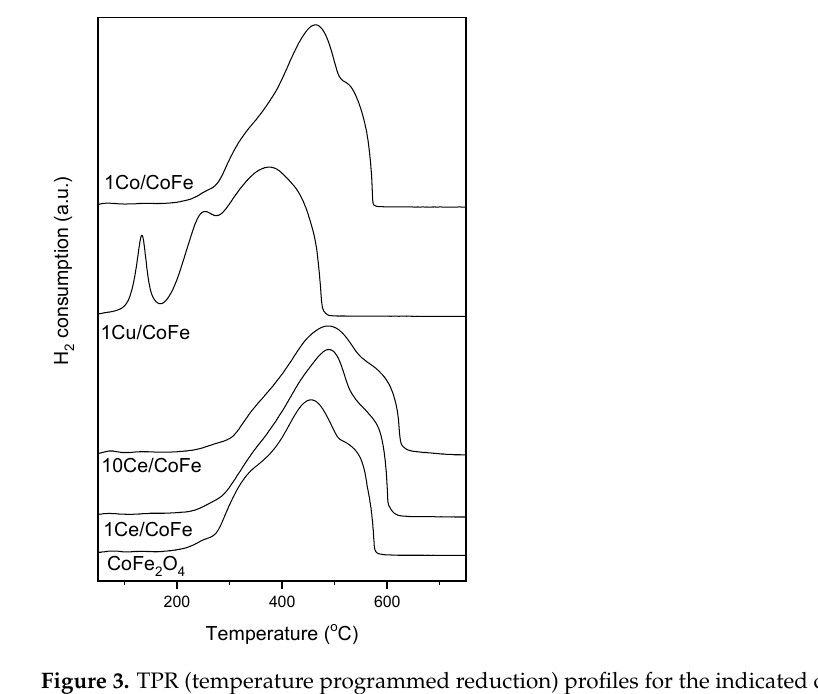
Figure 3. TPR (temperature programmed reduction) profiles for the indicated catalysts.